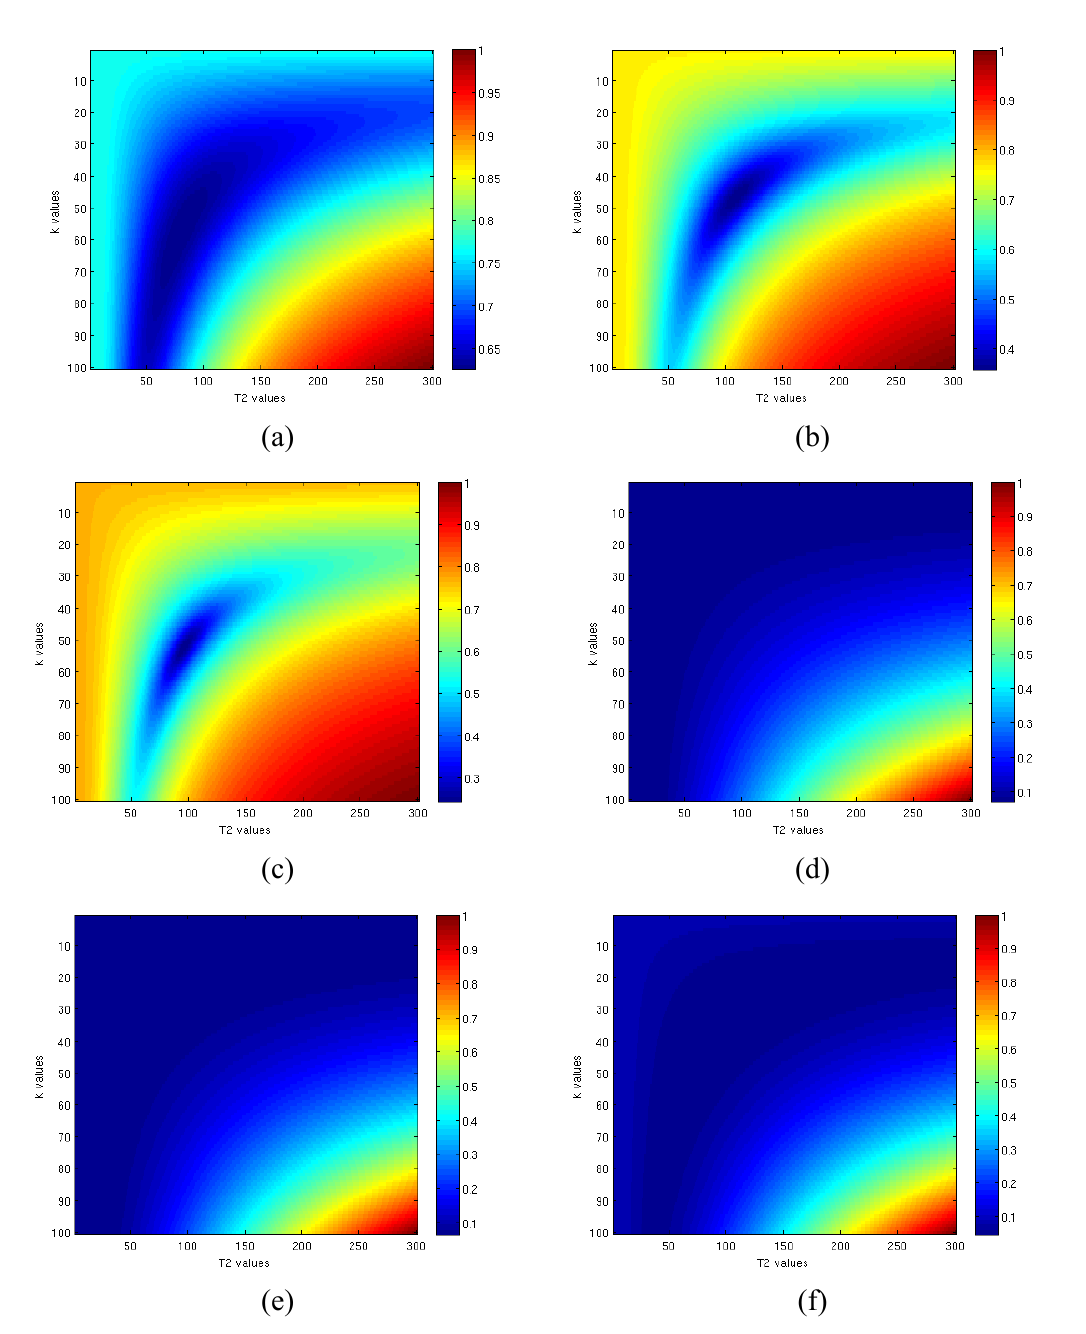
Figure 10. Behaviors of normalized functions to be minimized in case of Gaussian Complex Model (a-c) and Rician model (e-f) for SNR = 1 (a,d), SNR = 3 (b,e) and SNR = 5